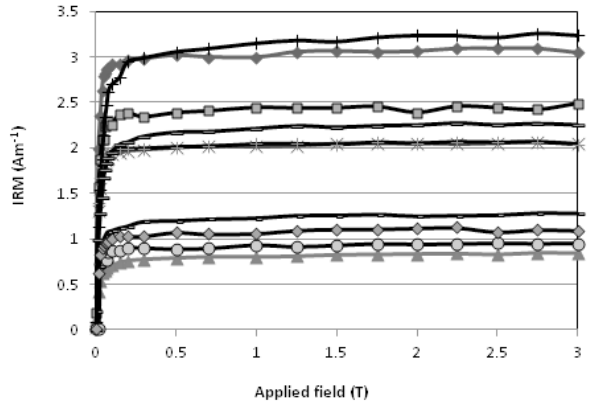
Fig. 5. Acquisition curves of IRM up to